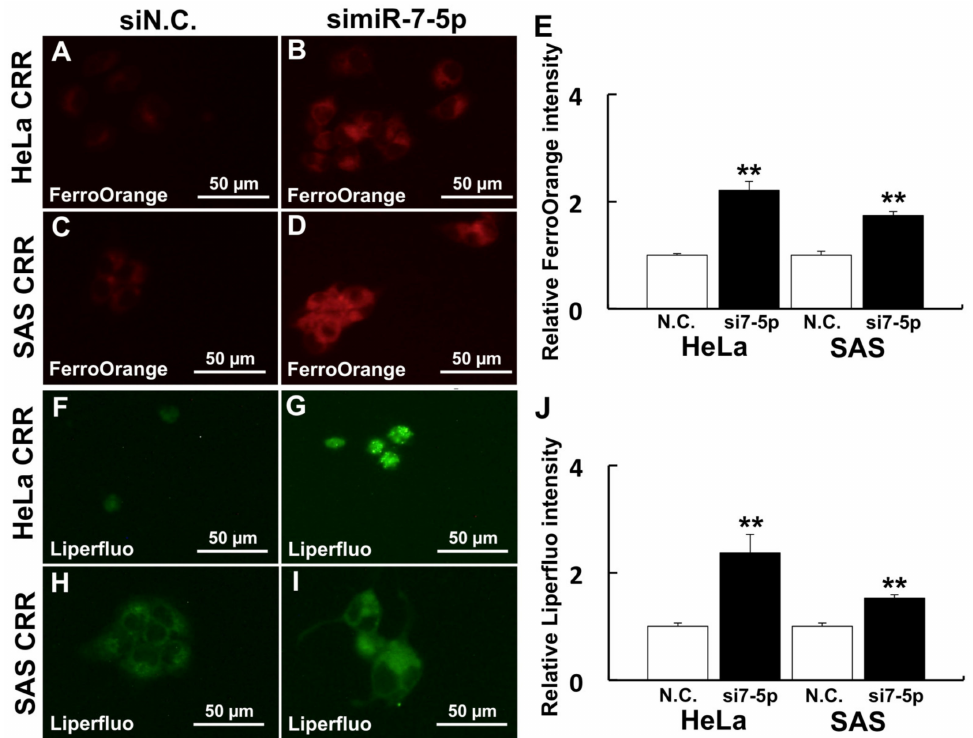
Figure 4. Knockdown of miR-7-5p enhances Fe 2+ and ferroptosis marker. Cells were treated with 1 µ M FerroOrange and 20 µ M Liperfluo to detect intracellular Fe 2+ and lipid peroxidation after a miR-7-5p knockdown. ( A – E ) Intracellular Fe 2+ visualized by FerroOrange. ( F – J ) Ferroptosis marker visualized by Liperfluo. ( A , F ): HeLa CRR cells siN.C. treatment. ( B , G ) HeLa CRR cell simiR-7- 5p treatment. ( C , H ) SAS CRR cells siN.C. treatment. ( D , I ) SAS CRR cells simiR-7-5p treatment. ( E ) Relative FerroOrange intensity (HeLa CRR N.C.: n = 41, HeLa CRR simiR-7-5p: n = 72, SAS CRR N.C.: n = 16, SAS CRR simiR-7-5p: n = 63). ( J ) Relative Liperfluo intensity (HeLa CRR N.C.: n = 17, HeLa CRR simiR-7-5p: n = 12, SAS CRR N.C.: n = 32, SAS CRR simiR-7-5p: n = 51). **: p < 0.01